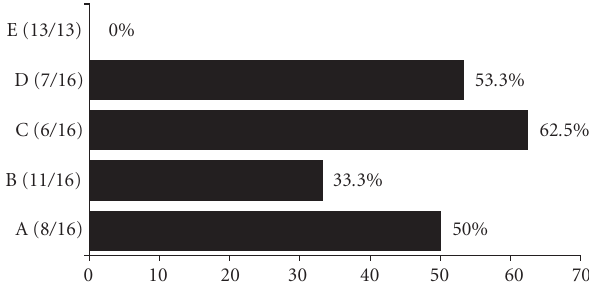
Figure 2: Mortality rate. Results are shown as the percentage of dead animals in each experimental group.Values in parentheses in- dicate the number of surviving animals compared with the total number of animals 7 days after induction of TNBS colitis. A, col- itic animals fed with the combination of 0.4% thyme and 0.2% oregano oils; B, colitic animals fed with the combination of 0.2% thyme and 0.1% oregano oils; C, colitic animals fed with the com- bination of 0.1% thyme and 0.05% oregano oils; D, animals with TNBS-induced colitis; E, control sham